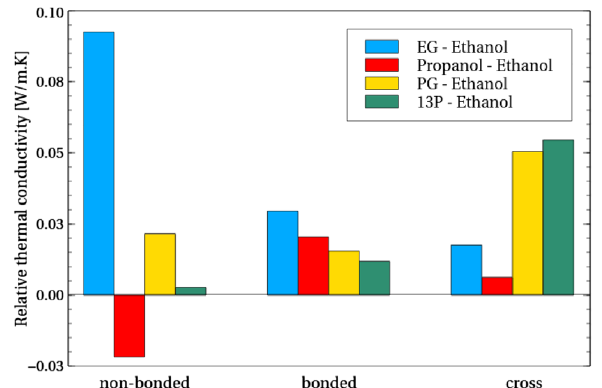
Figure 5. The change in conductivity contribution when adding atoms to ethanol. All values are shown relative to that for ethanol. A positive value means that the other molecule has a greater contribution than ethanol for that type of conduction.